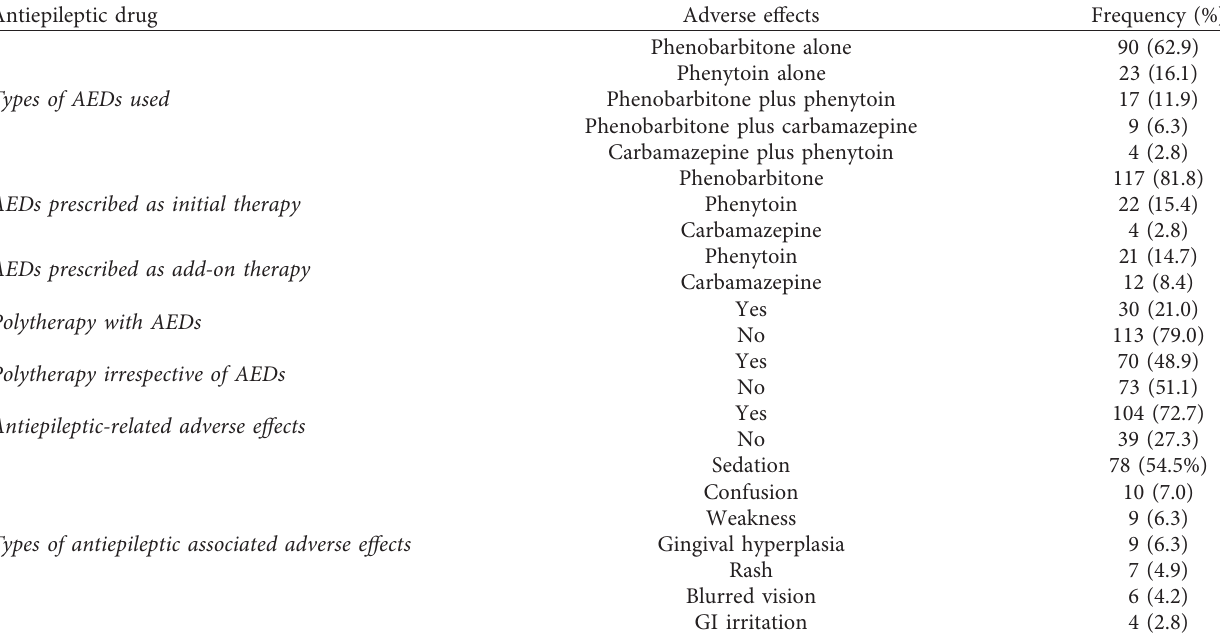
Polytherapy with AEDs